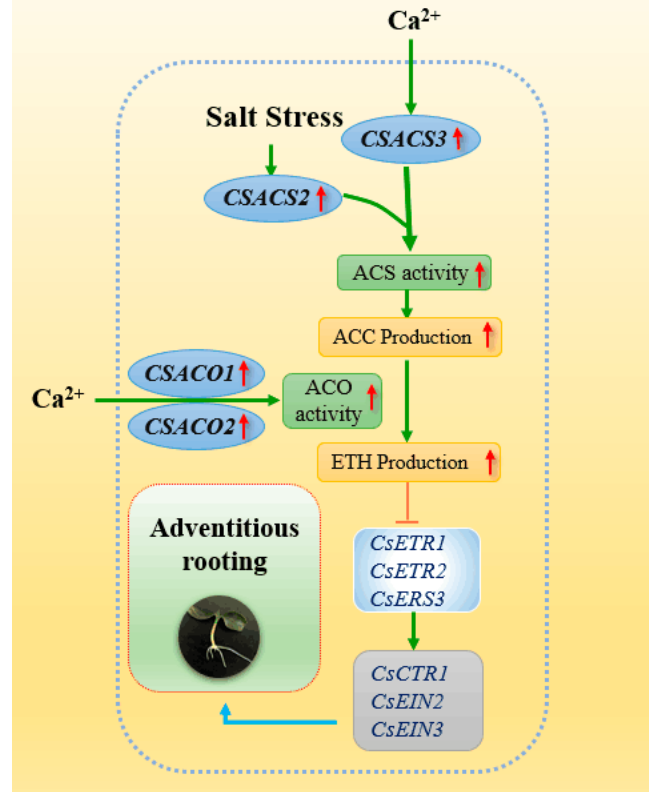
Figure 8. Schematic model of the signaling networks involving Ca 2+ and ethylene during adventitious rooting in cucumber under salt stress. Ca 2+ could promote the development of adventitious root under salt stress through regulating the activities and transcriptional levels of ACS and ACO enzyme to trigger endogenous ethylene accumulation. Meanwhile, the receptors and downstream components of ethylene signaling pathway could be regulated by Ca 2+ during adventitious rooting under salt stress. T bars, inhibition.